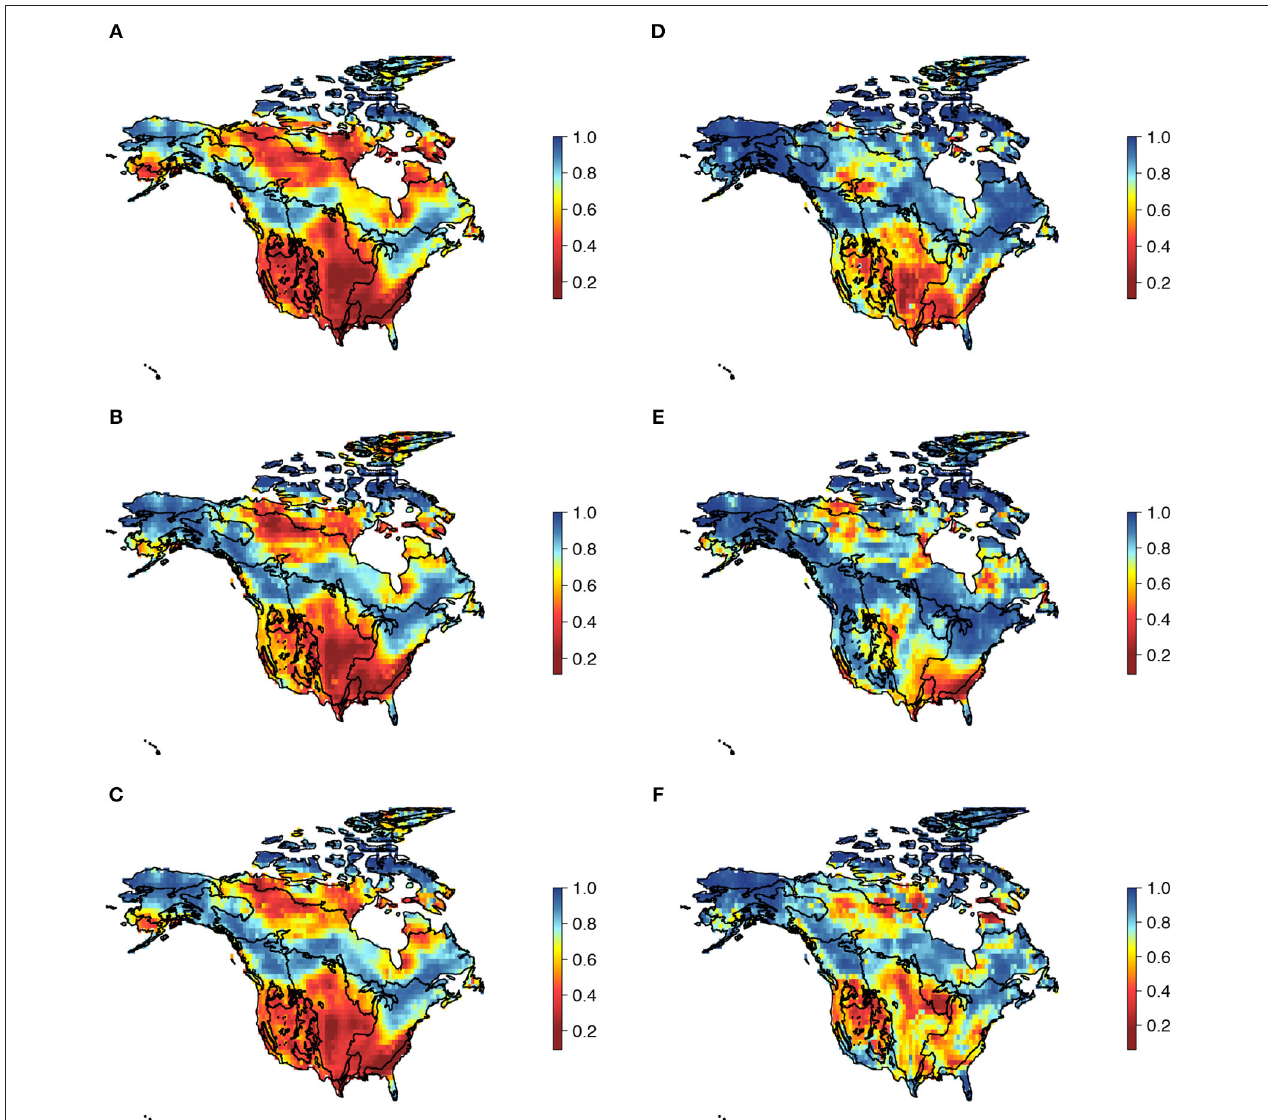
FIGURE 2 | Spatial patterns of beta diversity for three dimensions of North American vascular plant diversity and individual traits based on the proportion of beta diversity explained by turnover vs. nestedness. The maps show the relative importance ( β ratio ) of beta diversity components ( β nes and β sim ) for (A) taxonomic, (B) functional, and (C) phylogenetic diversity and variation in (D) whole plant height, (E) seed mass, and (F) specific leaf area. Values > 0.5 indicate strong influence of β nes (blue color cells) and values < 0.5 strong influence of β sim (red color cells).